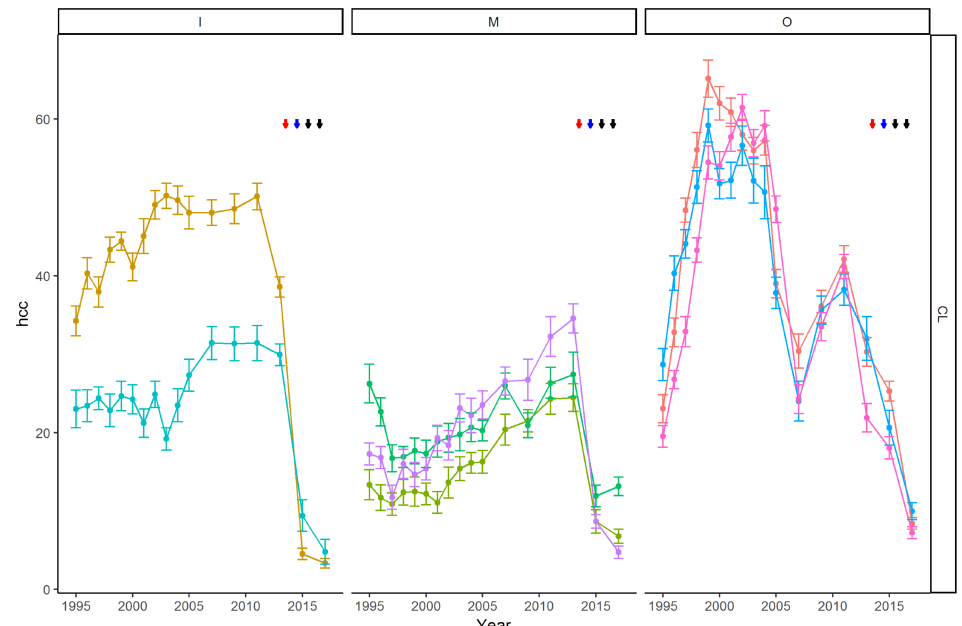
Figure A1. Temporal trends in hard coral cover in the Cooktown/Lizard Island sector of the Great Barrier Reef. Data are mean percent hard coral cover ± 1 SE for reefs at each of three positions across the continental shelf: I = inshore, M = mid-shelf, O = outer-shelf. Colour arrows show the occurrence of disturbances: red = Cyclone Ita, blue = Cyclone Nathan, black = bleaching.